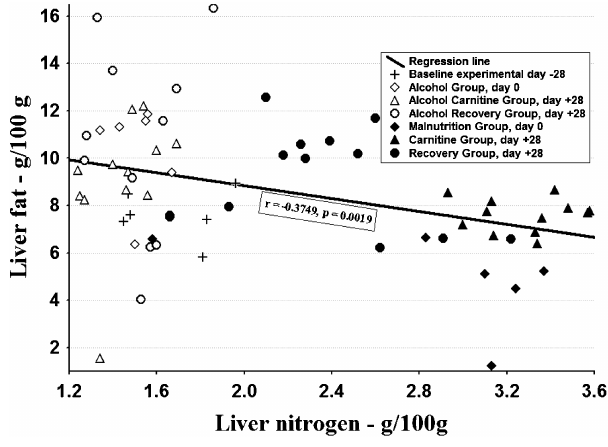
Figure 3 – Relation between liver nitrogen and liver fat during the experimental protocol. Note that undernourished alcoholic rats had lower hepatic nitrogen values and higher hepatic fat